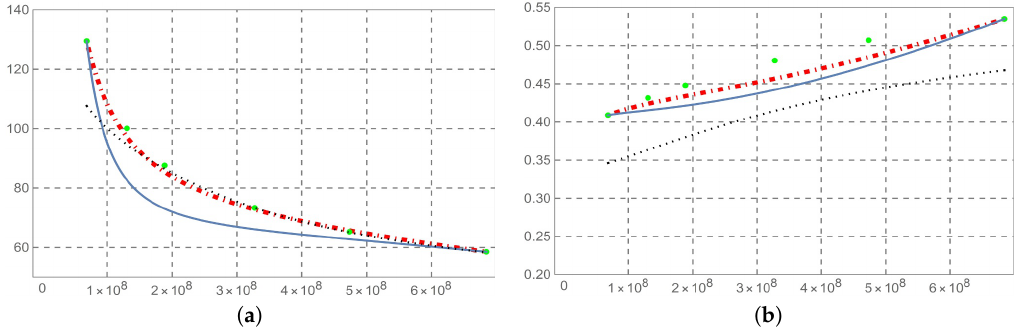
Figure 7. ( a ) Permittivity and ( b ) conductivity at frequencies 10 MHz @ 100 MHz. Line dot-dashed fractional model α = 0.936, line continue ordinary model, line dotted extensive Cole–Cole’s model, points experimental data.